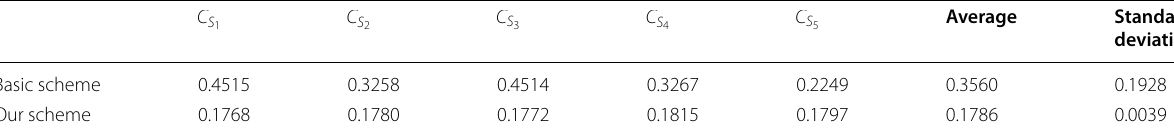
Table 2 Results of evaluation method with one shared